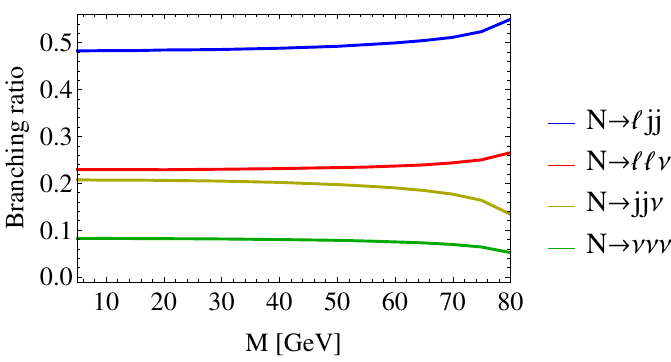
Figure 4 . Branching ratios of heavy neutrino decays. The colour code denotes the di(cid:11)erent possible (cid:12)nal states, namely the semileptonic lepton-dijet (\ ‘jj ", blue line), the dilepton (\ ‘‘(cid:23) ", red line), the dijet (\ jj(cid:23) ", yellow line), and the invisible decays (\ (cid:23)(cid:23)(cid:23) ", green line). The semileptonic and leptonic branching ratios are summed over all lepton